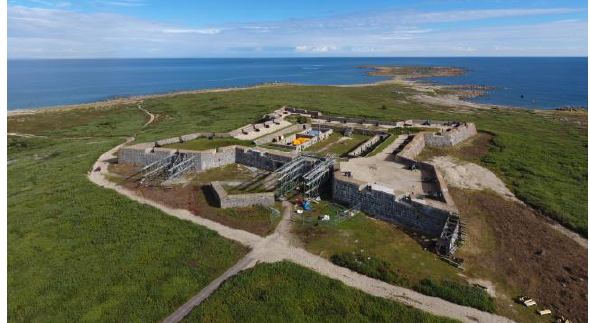
Figure 8: Prince of Wales Fort (taken by Alex